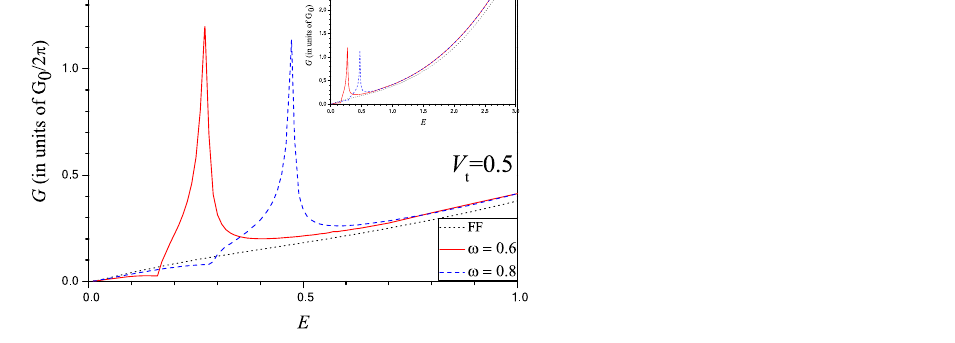
Figure 8. Same as Fig. 7 but for the barrier along the Г–X direction for D = 1 and V 0 = 3. Dot (black) for FF; Solid (red) for V t = 0.5 and ω = 0.6; Dash (blue) for V t = 0.5 and ω = 0.8. INSET: For entire energy range under below barrier